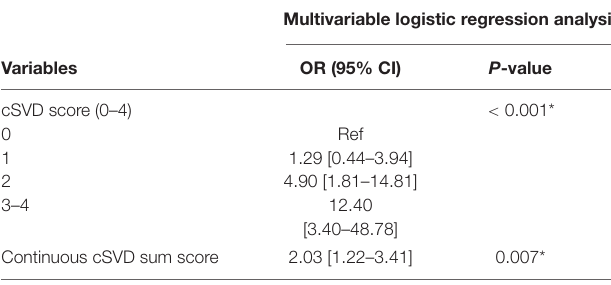
TABLE 4 | Association of cSVD score and any ICH risk after IVT using LASSO multivariate logistic regression analysis. Multivariable logistic regression analysis